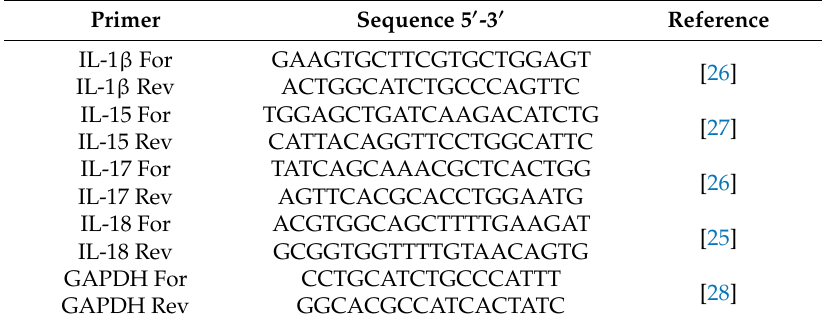
Table 2. List of primers utilized in RT-qPCR for cytokine transcript detection. Primer Sequence 5 (cid:48) -3